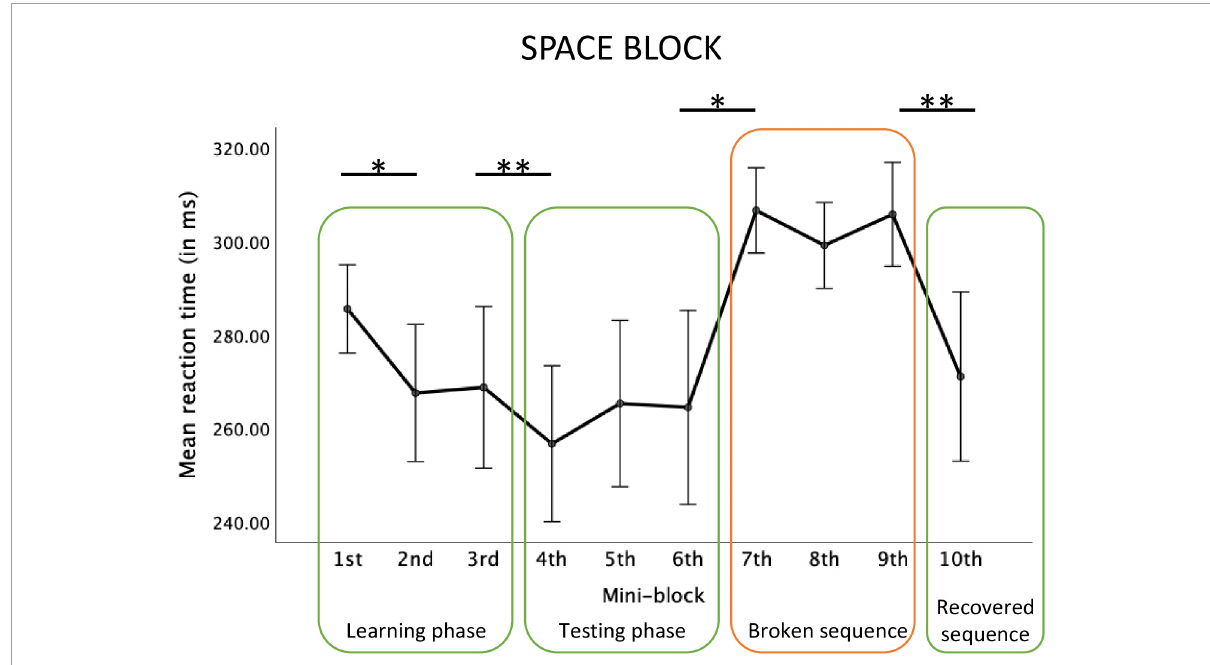
FIGURE3 Reaction times in each mini-block of the big Space block. Error bars represent ± 1 standard error. ∗ Stands for p < 0.05, ∗∗ stands for p < 0.01.